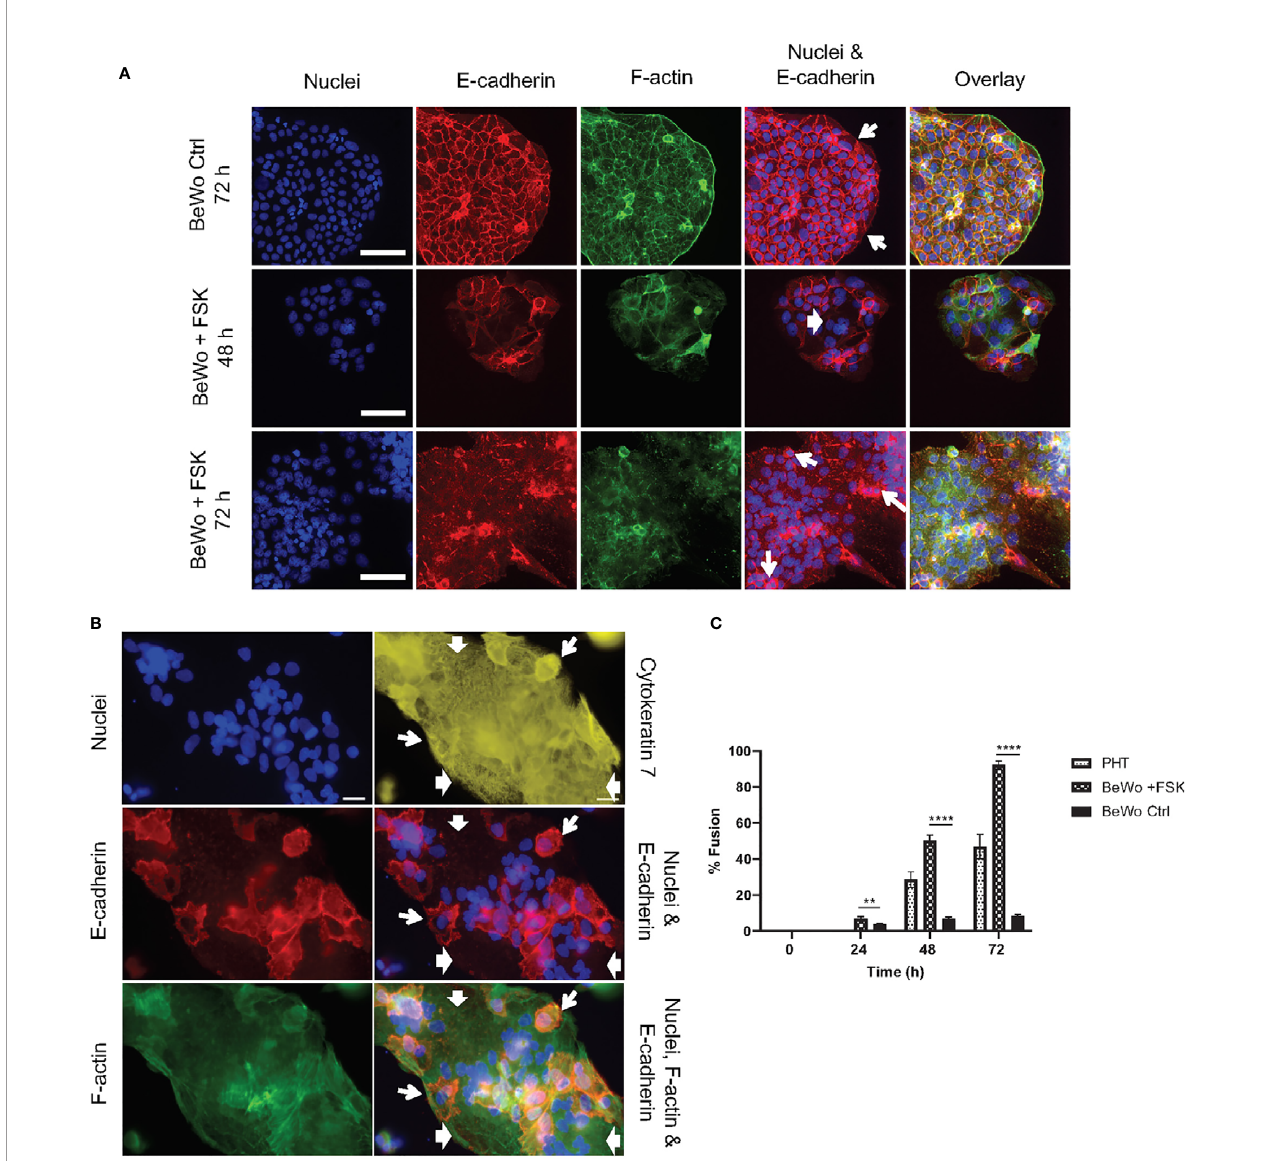
FIGURE 1 | Trophoblast culture models. (A) BeWo cells were cultured 24 h prior to daily treatment with 20 µM forskolin (BeWo +FSK), or with 0.1% control DMSO (BeWo Ctrl), for up to 72 h. Cells were fi xed and fl uorescently labeled to visualize nuclei (DAPI), F-actin (phalloidin-Alexa Fluor 568), and intercellular junctions (E- cadherin, Alexa Fluor 488-conjugated antibodies). Fluorescence images were acquired with a 20X objective (scale bar = 100 m m). (B) Primary human trophoblasts (PHT) were cultured for 72 h before fi xation and fl uorescence labeling to visualize nuclei (DAPI), intercellular junctions (E-cadherin, Alexa Fluor 568-conjugated antibodies), F-actin (phalloidin-AlexaFluor 488), and trophoblasts (cytokeratin 7, Alexa Fluor 647-conjugated antibodies). Fluorescence images were acquired with a 40X objective (scale bar = 50 m m). In (A, B) , wide arrows highlight examples of fused cells visualized by the absence of E-cadherin and the presence of multiple nuclei. Narrow arrows highlight some mononuclear non-fused cells delineated by continuous E-cadherin junctions. (C) PHT were analyzed after 48 h and 72 h of culture and BeWo cells were analyzed 0, 24, 48, and 72 h after FSK treatment. At least 2,000 – 3,000 nuclei were counted per experimental condition. Data are expressed as Percent Cell Fusion ± SEM. Statistical signi fi cance was determined using the Two-stage linear step-up procedure of Benjamini, Krieger and Yekutieli, with Q = 1%. Each row was analyzed individually, without assuming a consistent SD. **P = 0.0083, ****P < 0.000001 (n = 4 placentas for PHT, n = 3 for